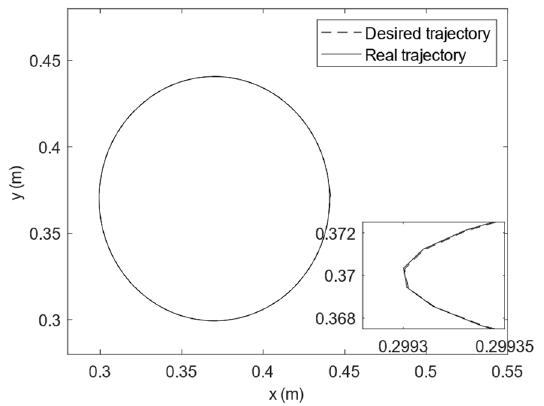
Table 3. Tacking position and orientation errors in the case of the second trajectory. Figure 8. 3D orientation behavior of UR5 in the presence of the proposed controller.